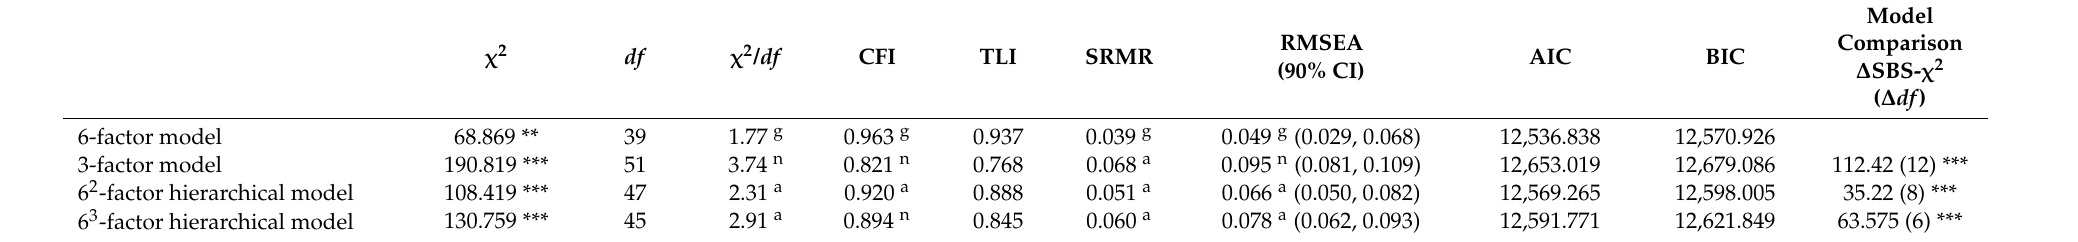
Table 2. Goodness-of-fit indices of the tested models ( N =